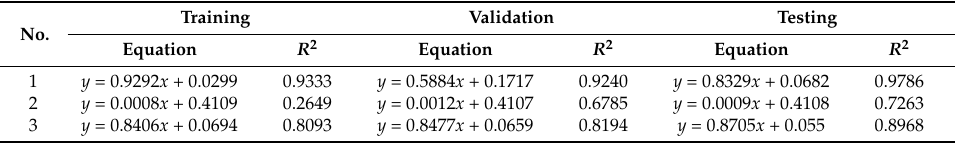
Table 5. Results of the different SOFM models in the training, validation, and testing phases.